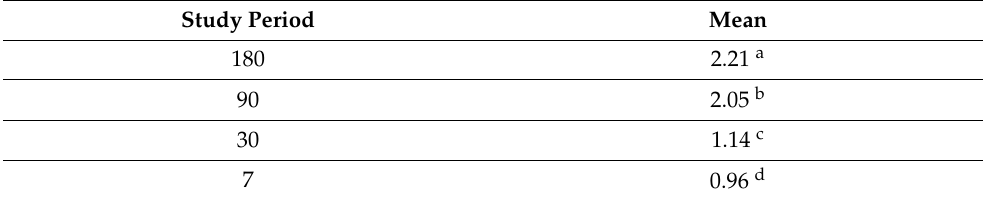
Table 10. Comparison of overall WSL (%) means among time periods investigated in the study using Tukey Multiple comparisons